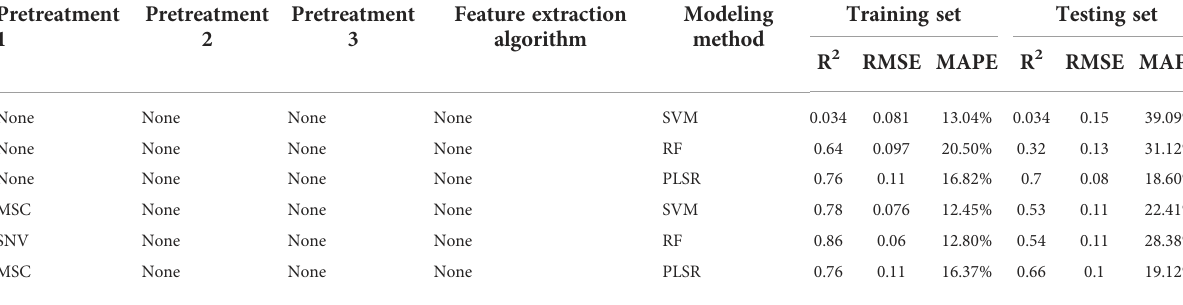
TABLE 3 Evaluation results of different prediction